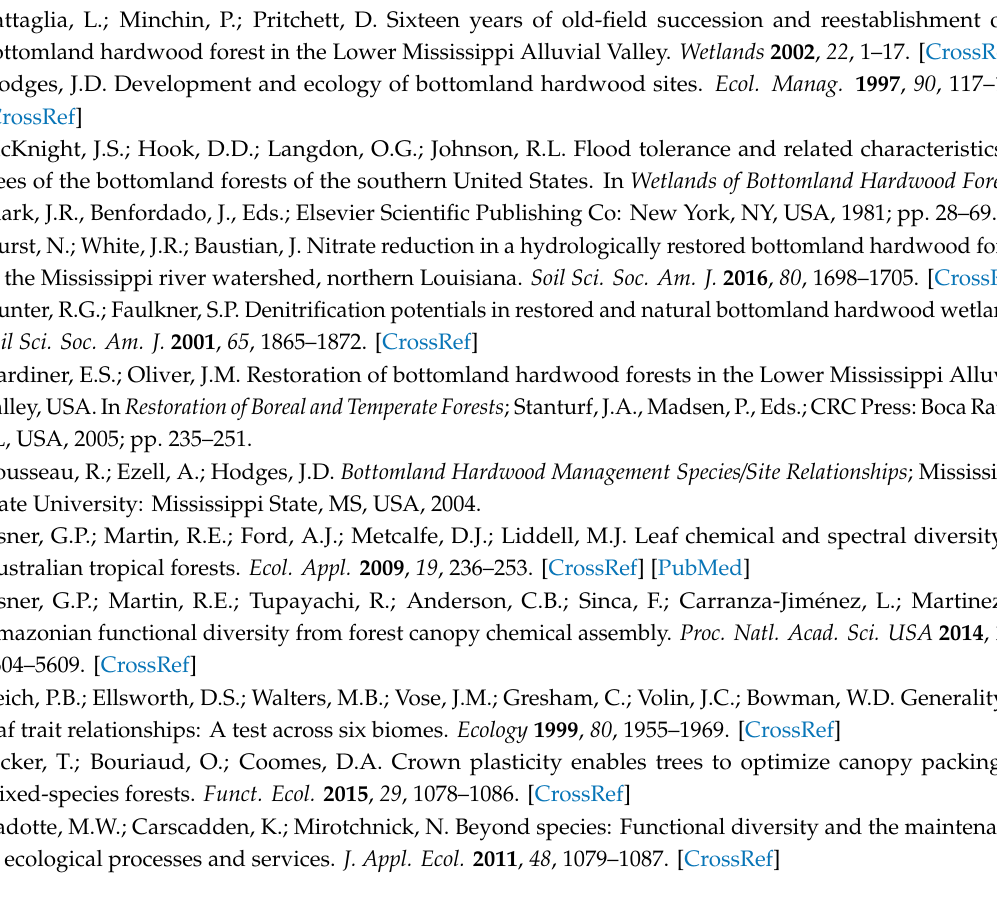
Table S1: Sizes of trees measured for physiological parameters including diameter at breast height (DBH), height, height to live crown and mean crown width. Figure S1: Significant correlations between stomatal density (mm − 2 ) and (a) total tree height (m) and (b) tree diameter at breast height (DBH;